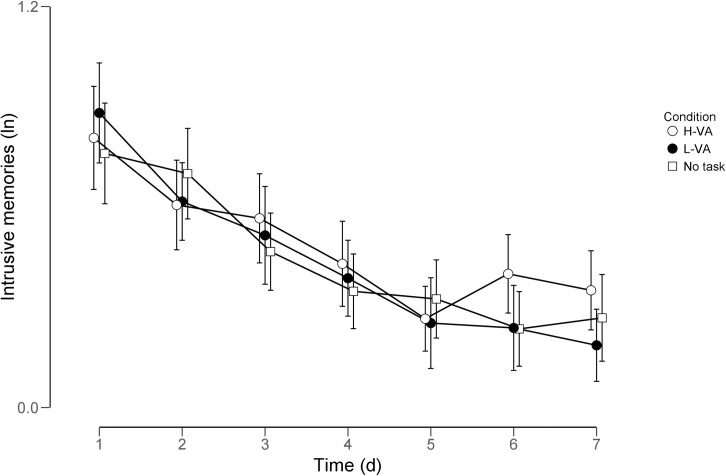
Intrusive memories (log-transformed) per condition per day.Error bars indicate 95% confidence intervals.